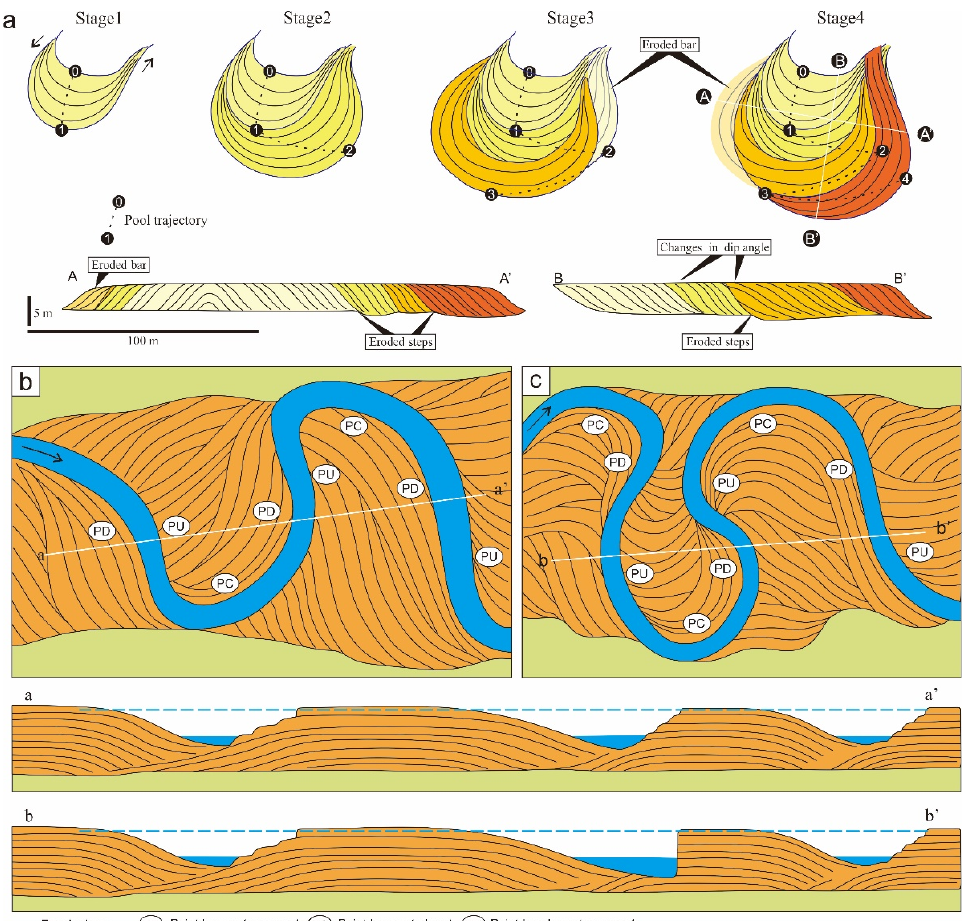
Figure 13. Cross section of composite model, highlighting the main structural factors of the migration and transformation of the meandering channel: ( a ) the asymmetric point bar of compound model, showing the planform evolution and internal architecture of the expanding four stages of pool zone migration[30]; ( b ) translation and ( c ) translation with rotation [57].